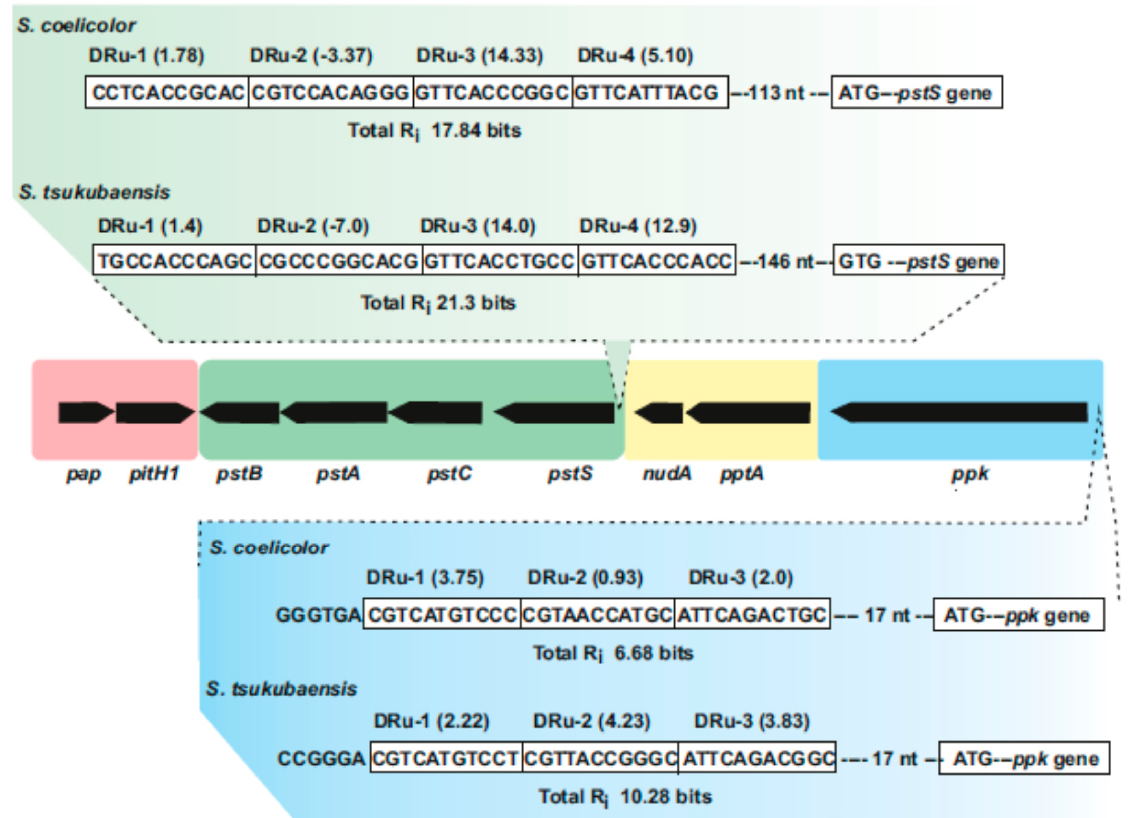
Figure 2. Supercluster of genes involved in phosphate uptake and metabolism in Streptomyces species. The central region includes the pap–pitH1 operon (shadowed in pink), the pstSCAB cluster (green), the pptA–nudA genes (yellow) and the ppk gene (blue). In the upper part, the PHO boxes upstream of pstS in S. coelicolor and Streptomyces tsukubaensis are shown indicating the direct repeat units (Dru’s) (boxed) and their individual information values (R i ). In the lower part updated PHO boxes upstream of the ppk gene in S. coelicolor and S. tsukubaensis are shown. Note that the pap–pitH1 operon is not regulated by phosphate and does not contain PHO boxes.